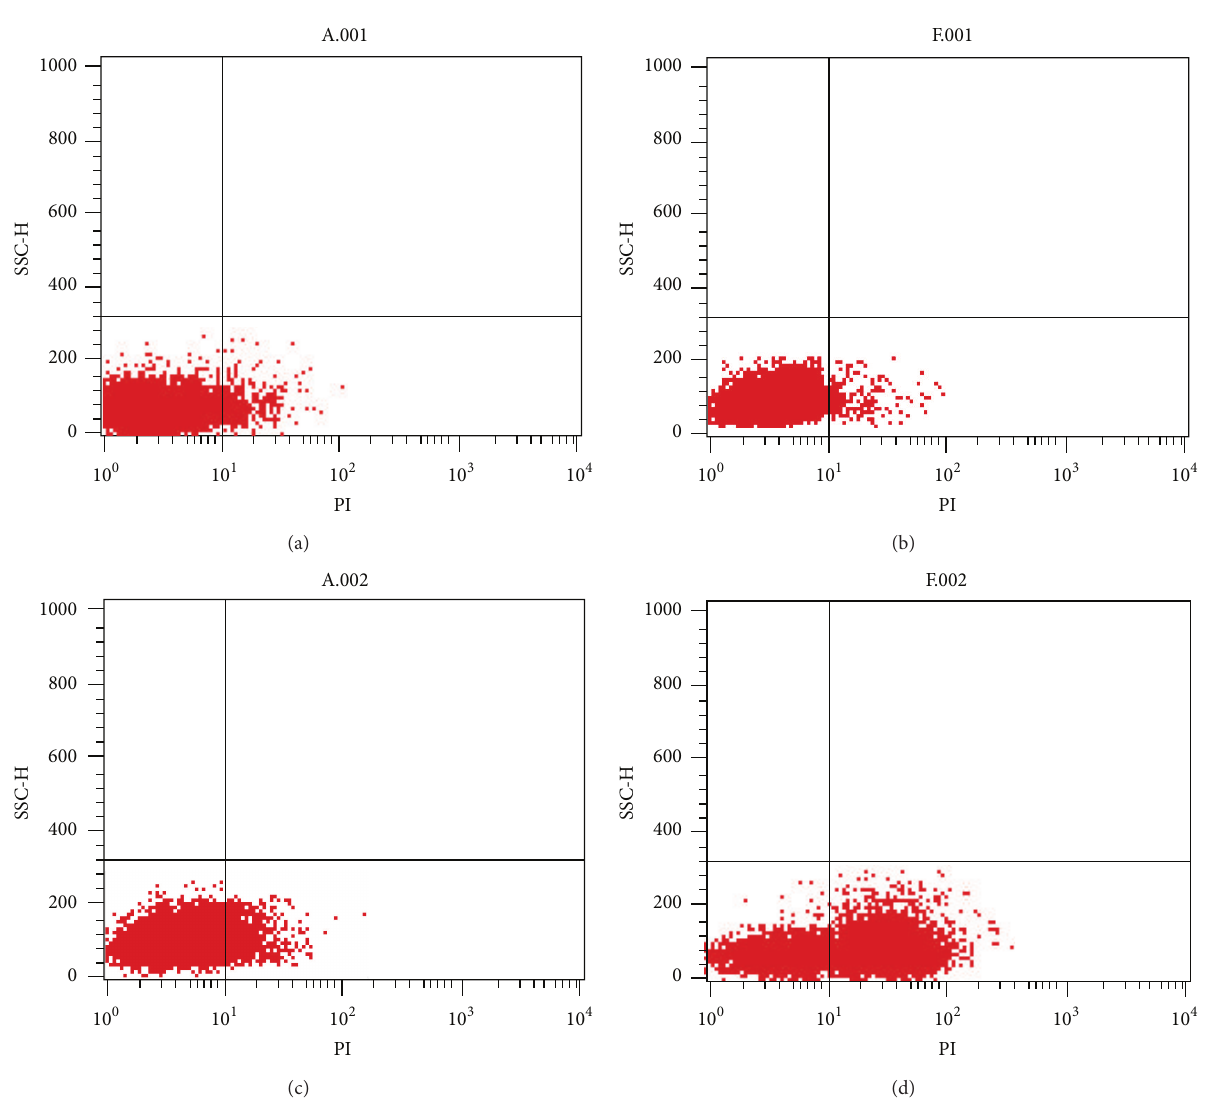
Figure 2: Membrane permeability of E. coli cells was measured using flow cytometry with PI staining after photodynamic treatment of hypocrellin B (25 𝜇 M), in which the energy density of blue light was 12J/cm 2 . (a) Sham control; (b) hypocrellin B treatment alone; (c) blue light irradiation alone; and (d) photodynamic treatment of hypocrellin